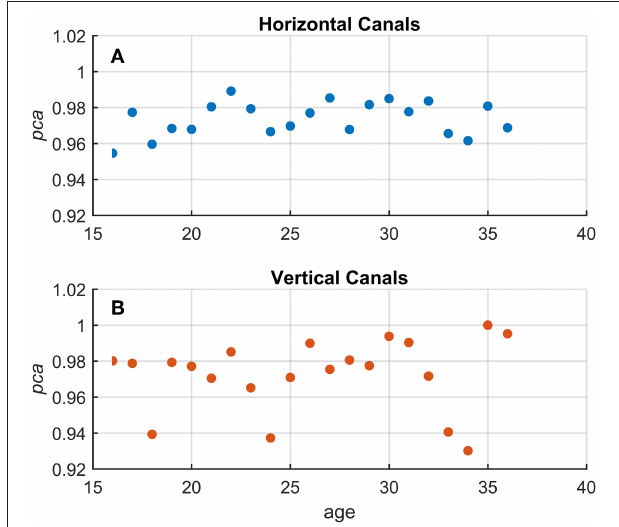
FIGURE 4 | Relationship between age and proportion of correct answers ( pca ) in the whole athlete group . Each point in the scatter plot represents a pca estimated in subgroups of athletes pooled by age (1-year-old bin). All pca were computed using the pooled approach (Equation 1) considering only head movements in the range of 2,001–6,000 deg/s 2 . As evident in the two scatter plots for fHIT performed in the horizontal ( A and blue points) and vertical ( B and red points), the point dispersal did not argument any potential correlation and/or interaction between the age and pca (i.e., test performance). The values of pca appear, indeed, randomly distributed regardless of age in a range between 1–0.95 and 1–0.92 for the horizontal and vertical canals, respectively.